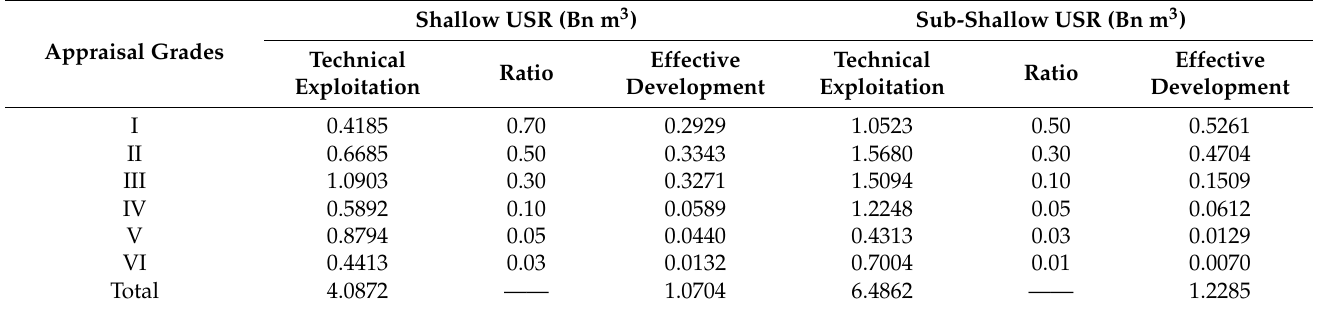
Table 13. Effective development capacity of USR for Yangzhou